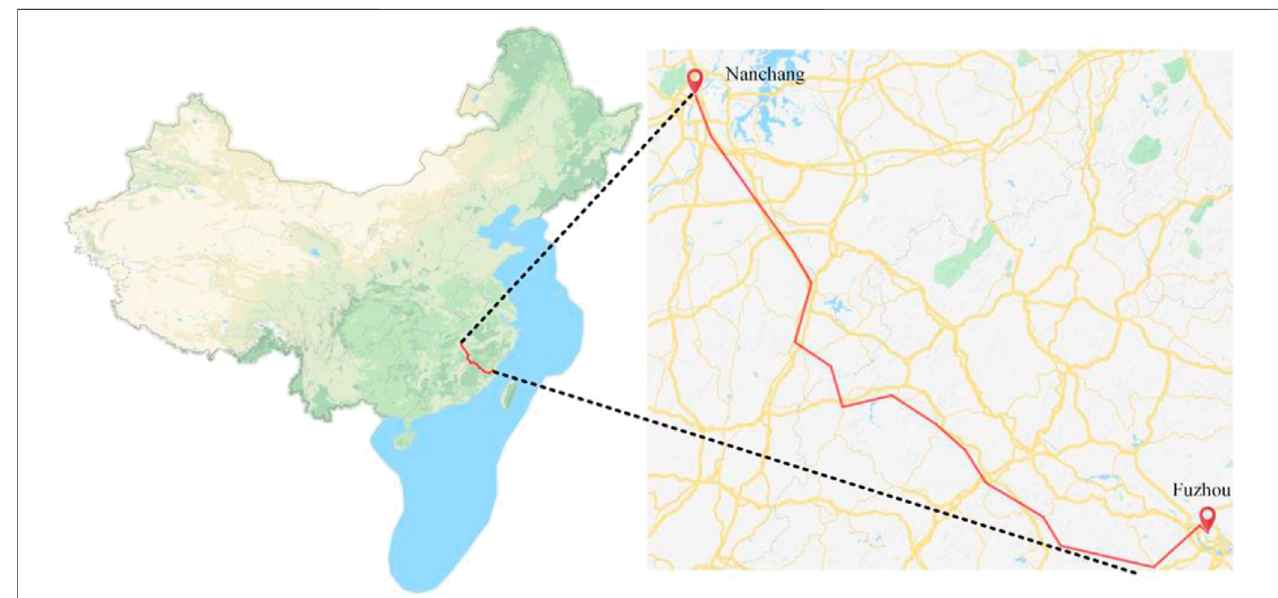
FIGURE 4 | Location of the Nanchang-Fuzhou rail line.